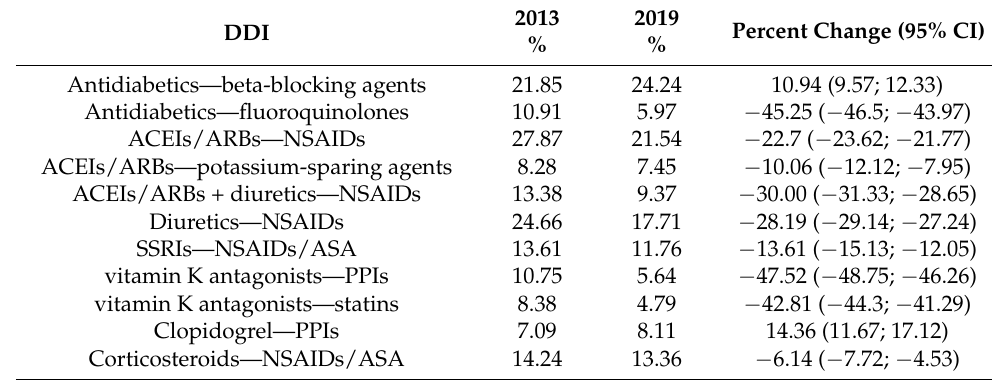
Figure 1. Trend in prevalence of DDIs involving antihypertensives and/or NSAIDs overall and by sex. 2013–2019, Piedmont region (Italy). Table 2. Relative change in DDI prevalence between 2013 and 2019 and the corresponding 95%